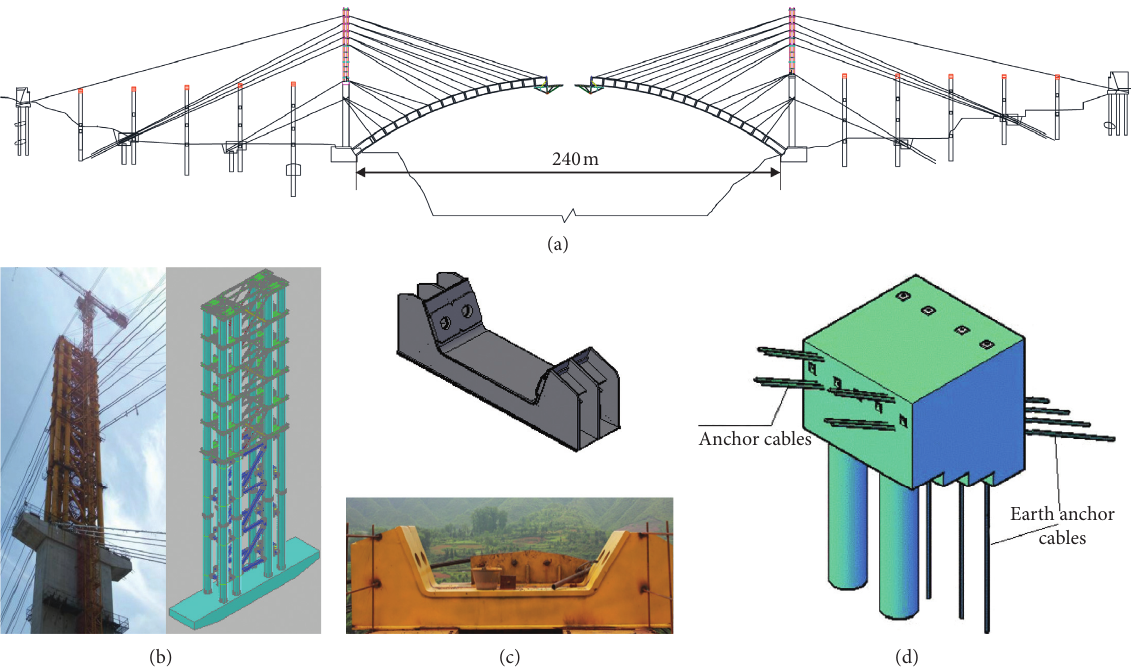
Figure 5: Structure of the buckle-anchor system. (a) Layout of the buckle-anchor system. (b) Steel buckle tower. (c) Steel anchor box. (d) Earth